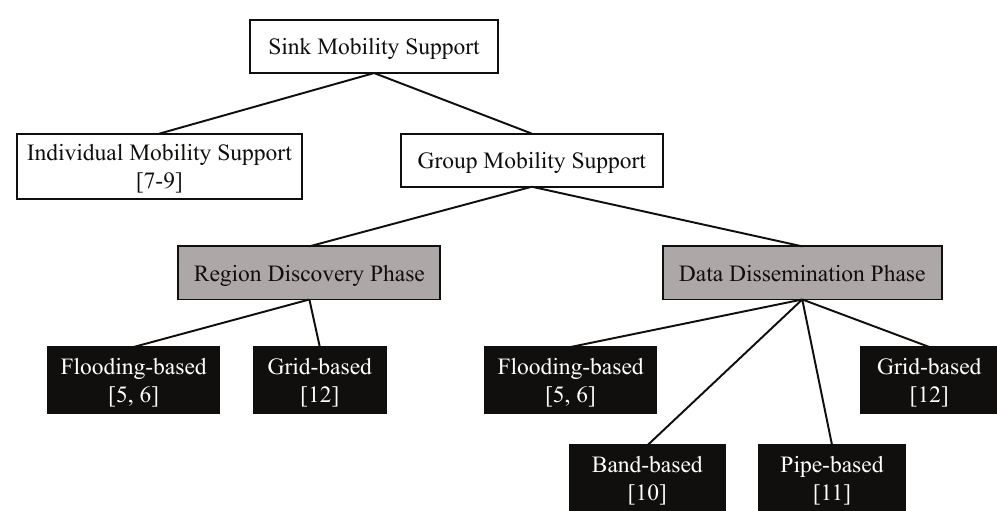
Figure 1. Taxonomy of sink mobility support